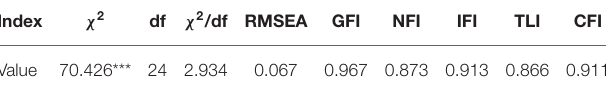
TABLE 2 | Fitting index for confirmatory factor analysis. TABLE 3 | Correlation analysis of each dimension of the